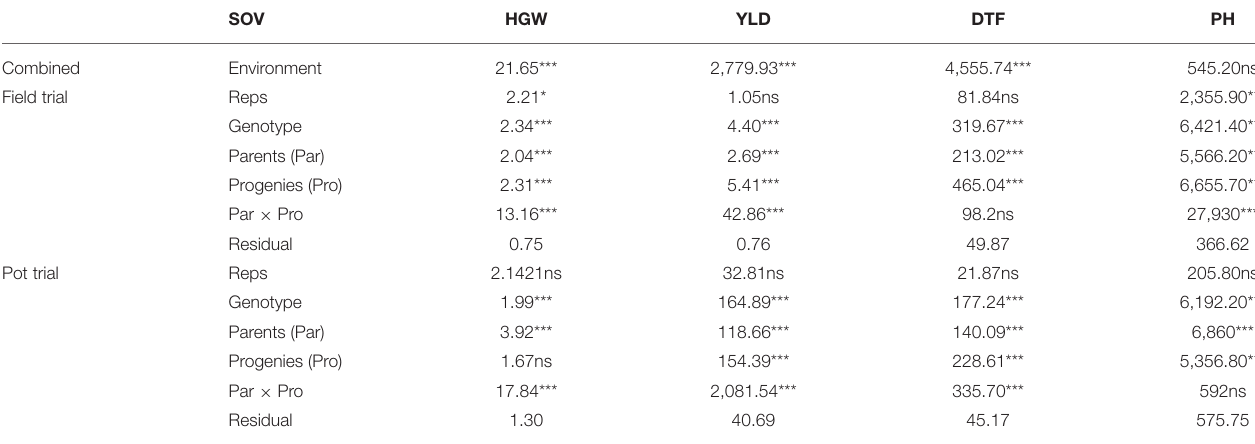
TABLE 2 | Mean squares of agronomic traits measured under field trial and pot trial. SOV HGW YLD DTF PH Combined